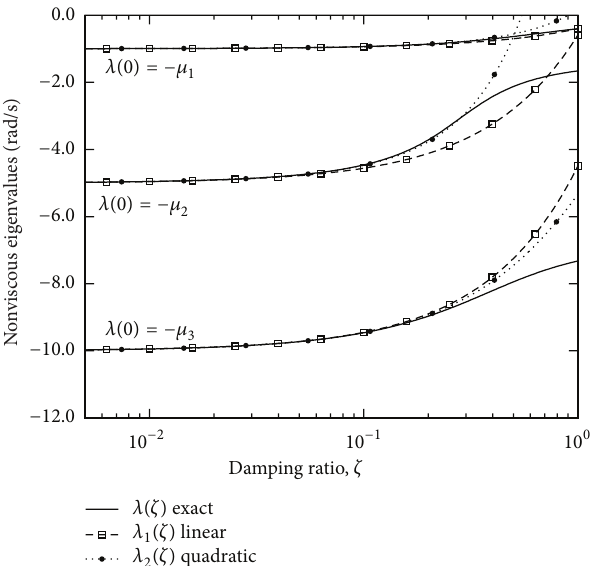
Figure6:ExactsolutionandTaylorseriesapproximation(quadratic and linear) of the nonviscous eigenvalues versus damping ratio 𝜁 . Biot’s model with 𝑁 = 3 kernels and nonviscous parameters 𝜇 𝑗 = {1,5,10}